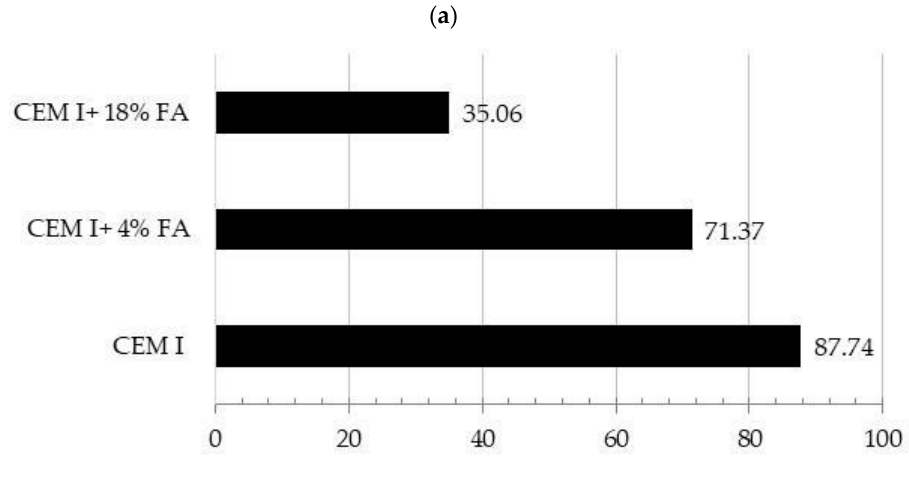
Figure 6. Strength of cement mortars with 4% and 18% addition of FA after 28 days of concrete curing: ( a ) compressive strength; ( b ) flexural strength.